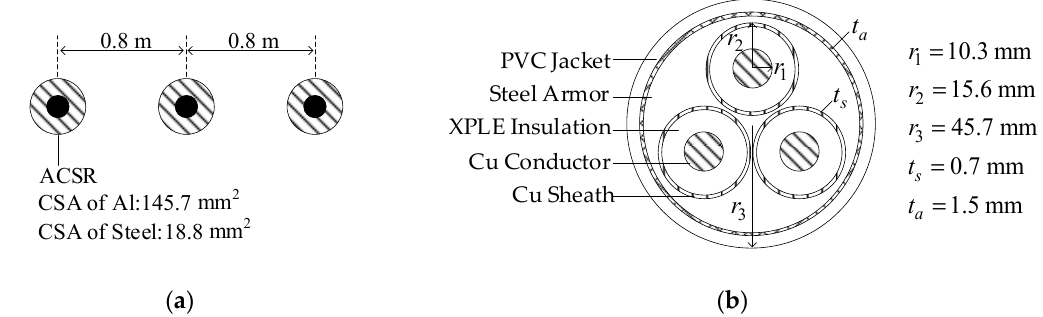
Figure 3. Layouts of medium-voltage power-lines: ( a ) the overhead lines and ( b ) the underground cables. ACSR is aluminum conductor steel reinforced, CSA is cross-sectional area, PVC is polyvinyl chloride, XPLE is cross-linked polyethylene.